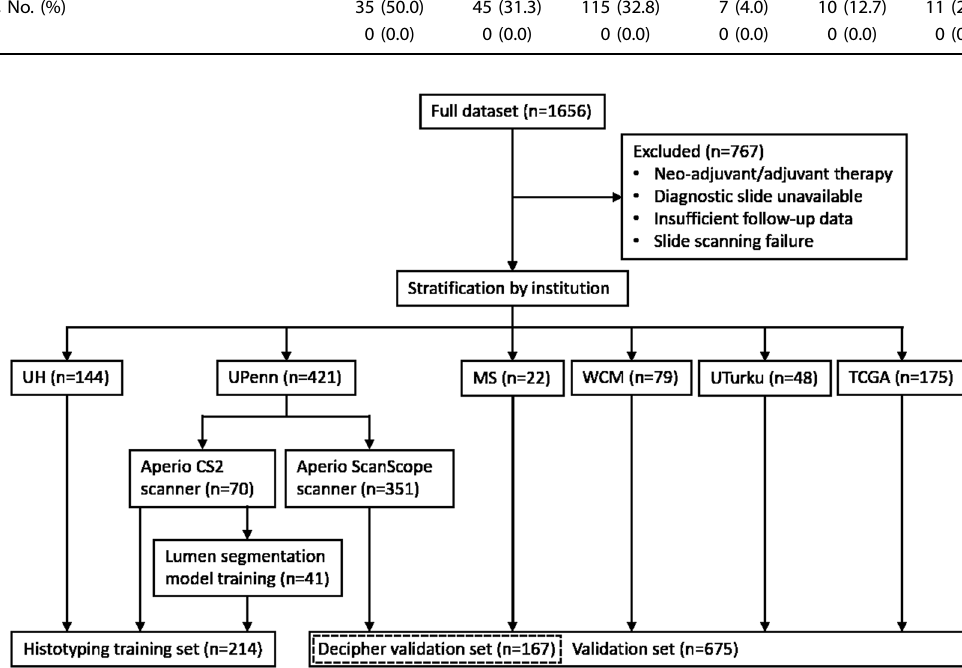
Fig. 6 CONSORT diagram of the allocation of patients in this